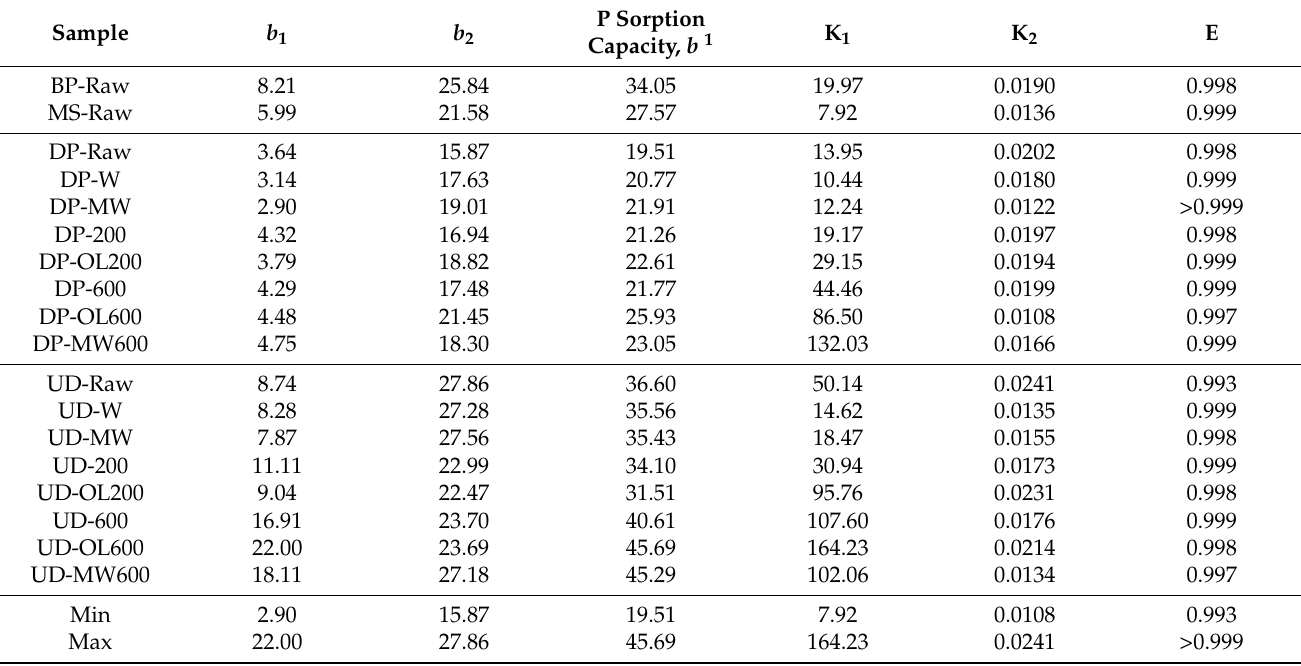
Table 4. Phosphorus sorption capacities and binding energy constants derived from two-surface Langmuir isotherms.